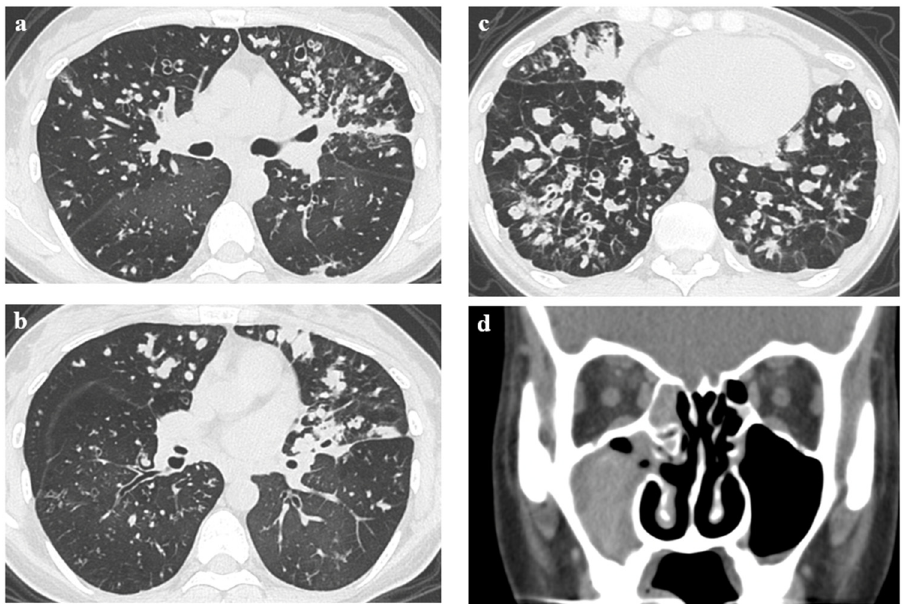
Figure 2. ( a – c ) Representative images of CT scan. Chest CT scan shows diffuse bronchial wall thickening, bronchial dilatation, and mucus plugs with bilateral middle and lower lung fields predominant; ( d ) A sinus CT scan shows fluid retention and mucosal thickening occupying the right maxillary